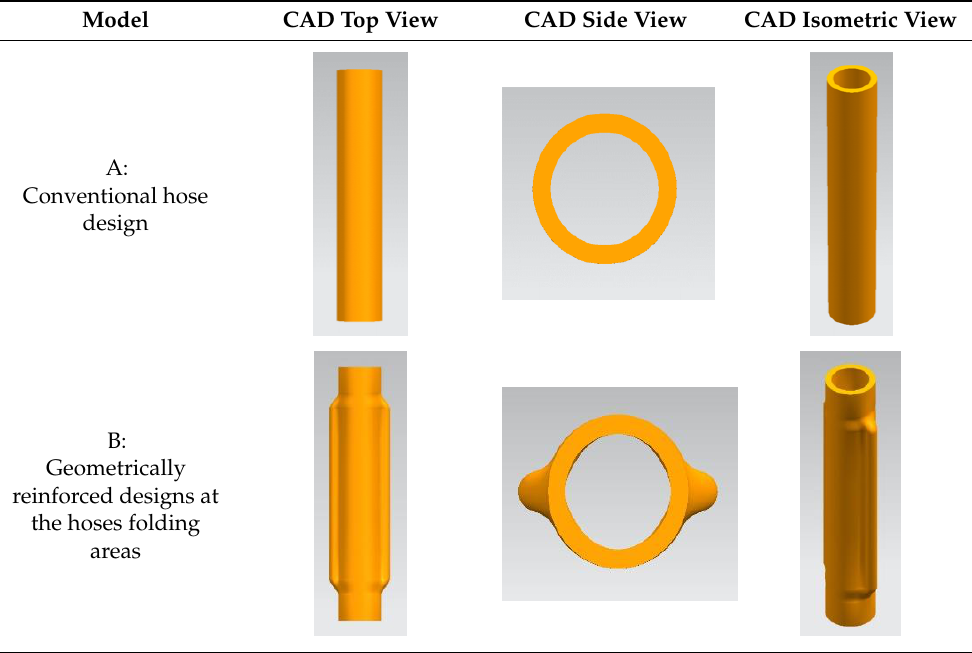
Table 1. Different views of hose designs A and B.